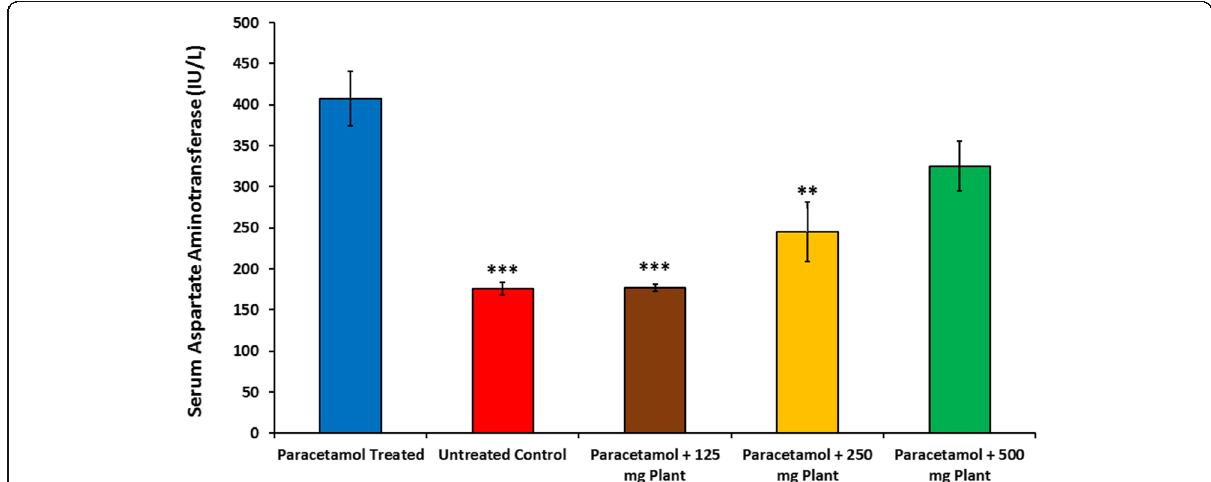
Fig. 2 Bar charts showing the effect of A. orientalis on liver function markers, serum AST in paracetamol treated, untreated control, paracetamol A. orientalis pretreated 125, 250, 500 mg/kg BW mice groups. Note that in all doses AST levels were significantly reduced compared to paracetamol treated mice group except at 250 mg/kg BW the reduction was insignificant. Data are presented as: mean ± SEM, n = 6, ** or *** P < 0.05 showed moderate or severe significant difference,